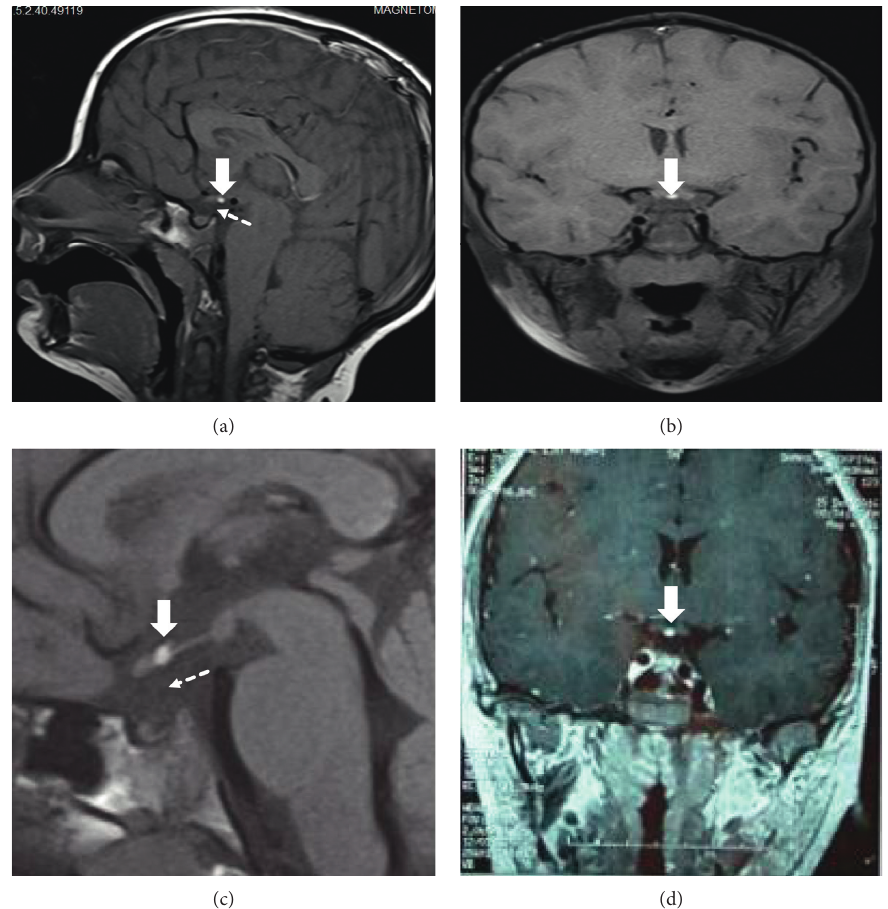
Figure 2: (a) The first patient’s sagittal MR image without contrast for the pituitary; the solid arrowhead points to the posterior pituitary lobe (bright spot), while the dashed arrowhead points to the supposed pituitary stalk which is absent. (b) Coronal image without contrast for the first case shows the ectopic bright spot close to the optic chiasm. (c) Noncontrast sagittal view for the pituitary in the secondcase where the solid arrow points to the ectopic bright spot and the dashed arrowhead points to the absence of pituitary stalk. (d) Contrast coronal image for the second